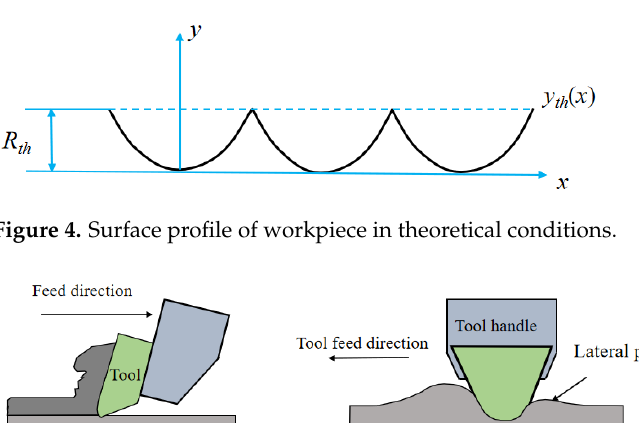
Figure 4. Surface profile of workpiece in theoretical conditions.